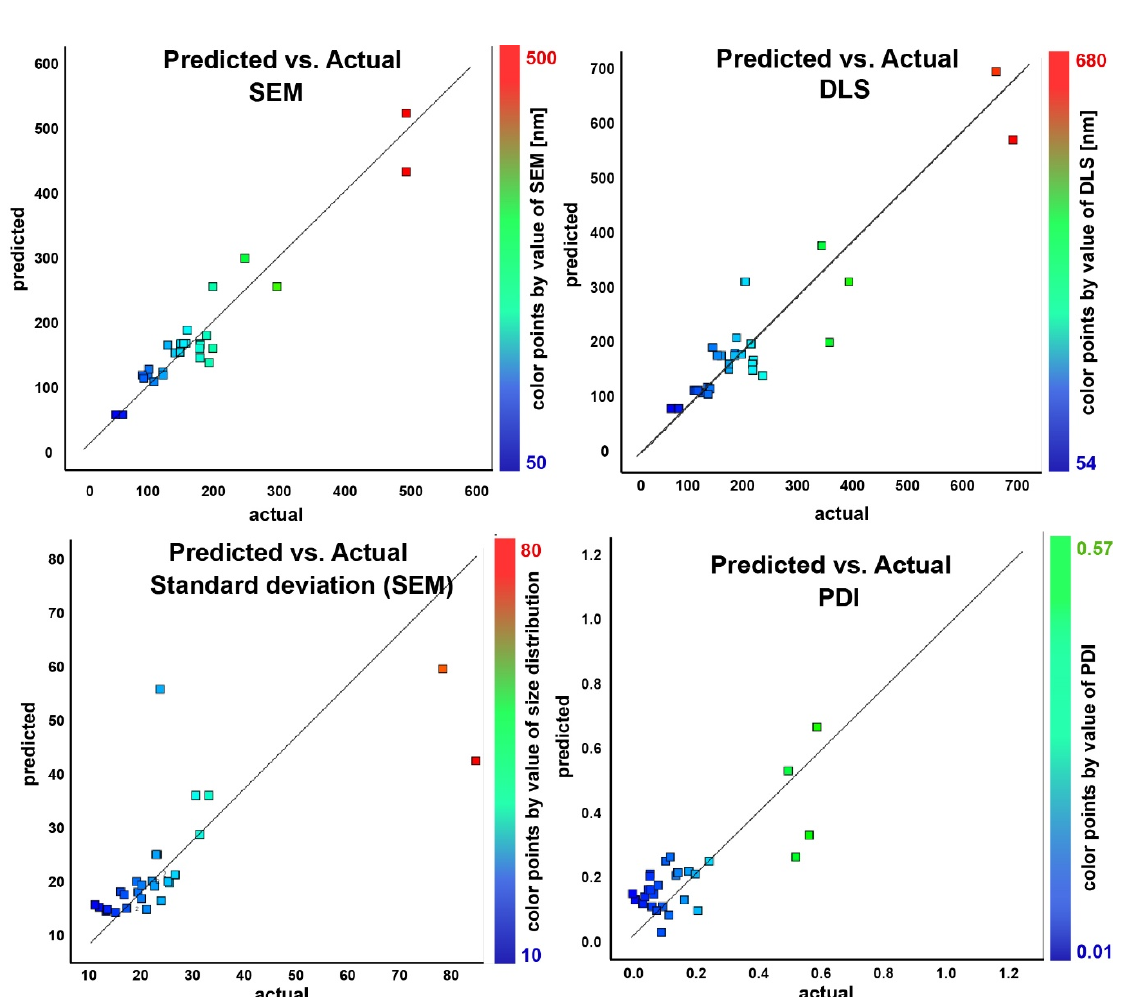
Figure 5. Linear regression plots of the predicted response vs. the obtained response for each experiment. The squares represent the thirty experiments of the model’s training set. The closer the squares are situated to the regression line, the higher the accuracy is of the predicted response.